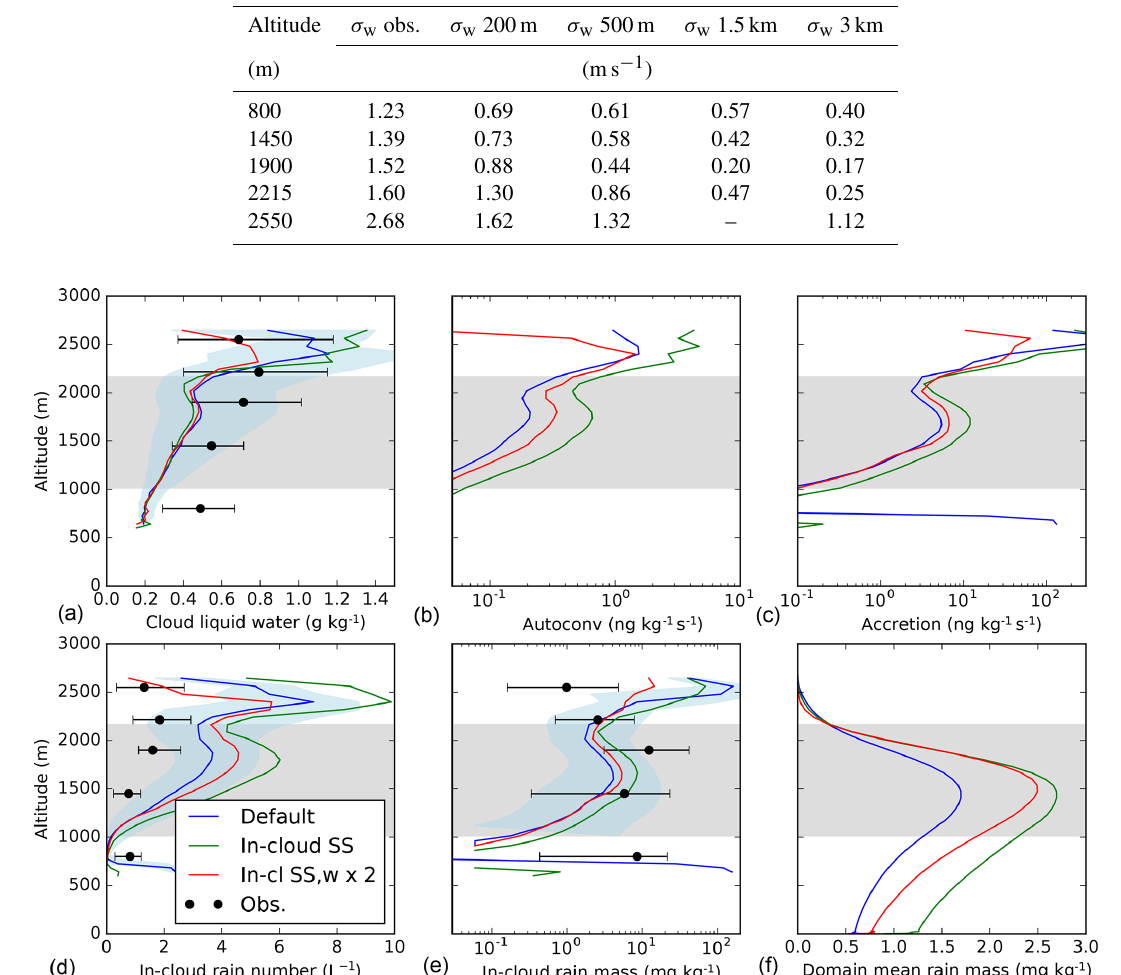
Table 4. Standard deviation of in-cloud updraught speed in observations and in simulations at four different resolutions on 19 August 2017 at 12:00UTC.